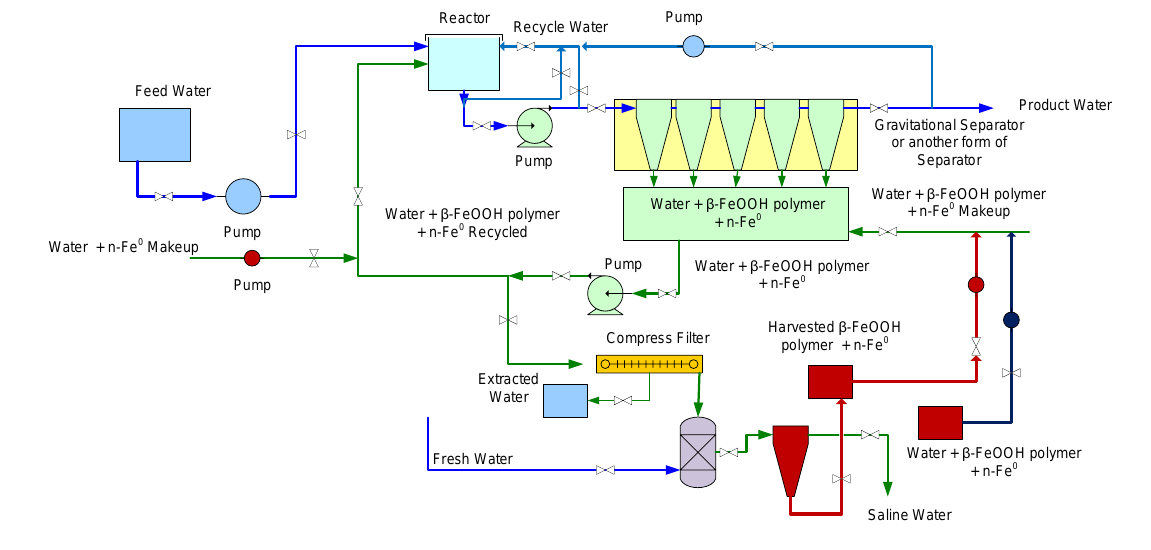
Figure 13. Process flow diagram for the partial desalination of irrigation water or flowback water using n-Fe 0 or a β -FeOOH polymer.